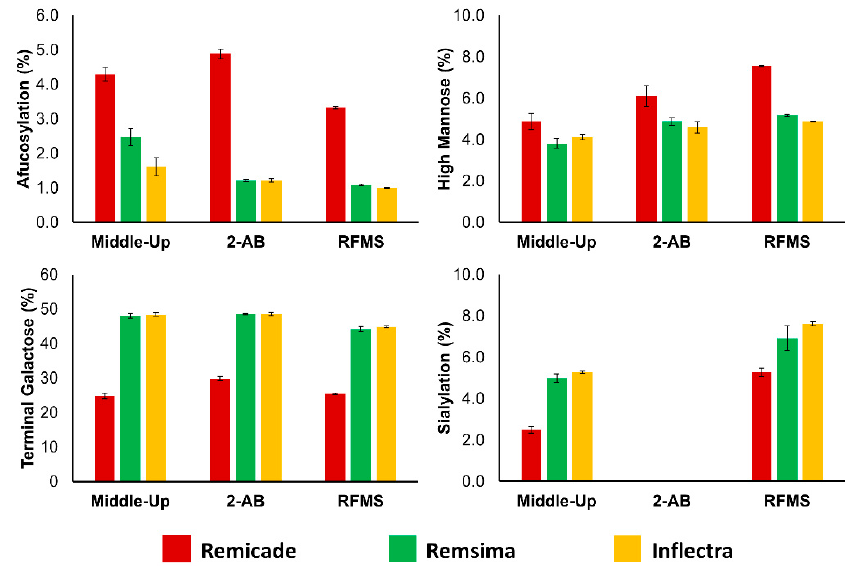
Figure 5. HILIC ‐ MS analysis of infliximab products Remicade ® , Remsima ® and Inflectra ® . ( A ) Fluo ‐ rescence chromatograms of the glycosylated scFc subunit of Remicade ® (red), Remsima ® (green) and Inflectra ® (yellow). ( B ) Zoom on the scFc subunit region with sections assigned for scFc subunits carrying afucosylated glycans, terminal galactosylated glycans and sialylated glycans.